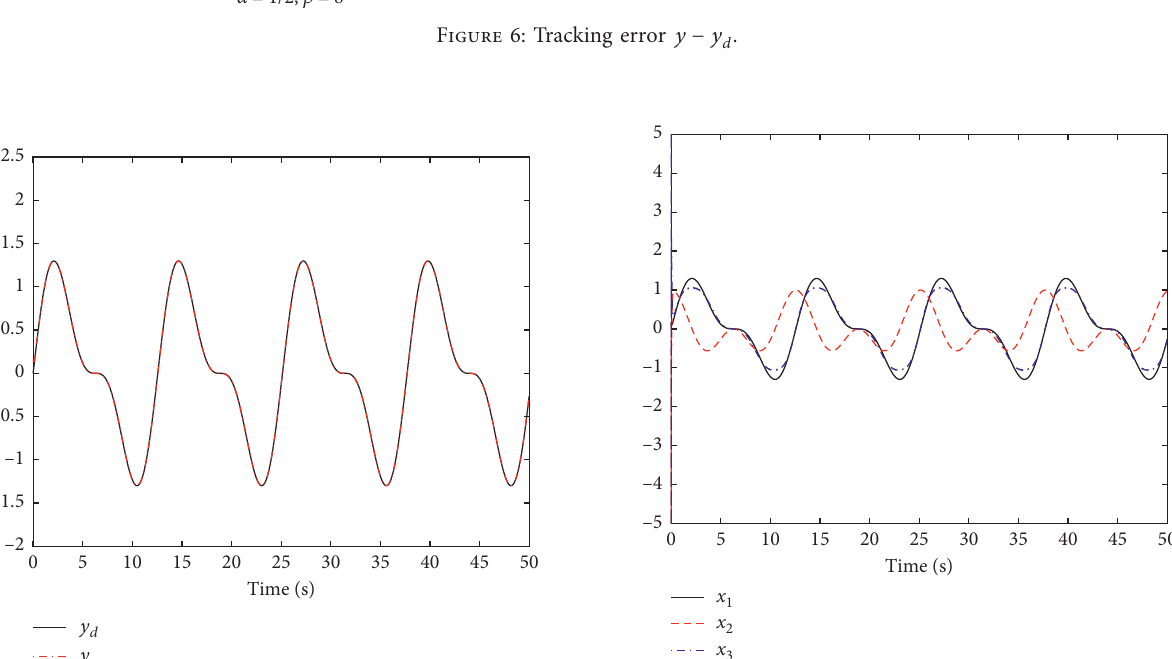
Figure 6: Tracking error y − y